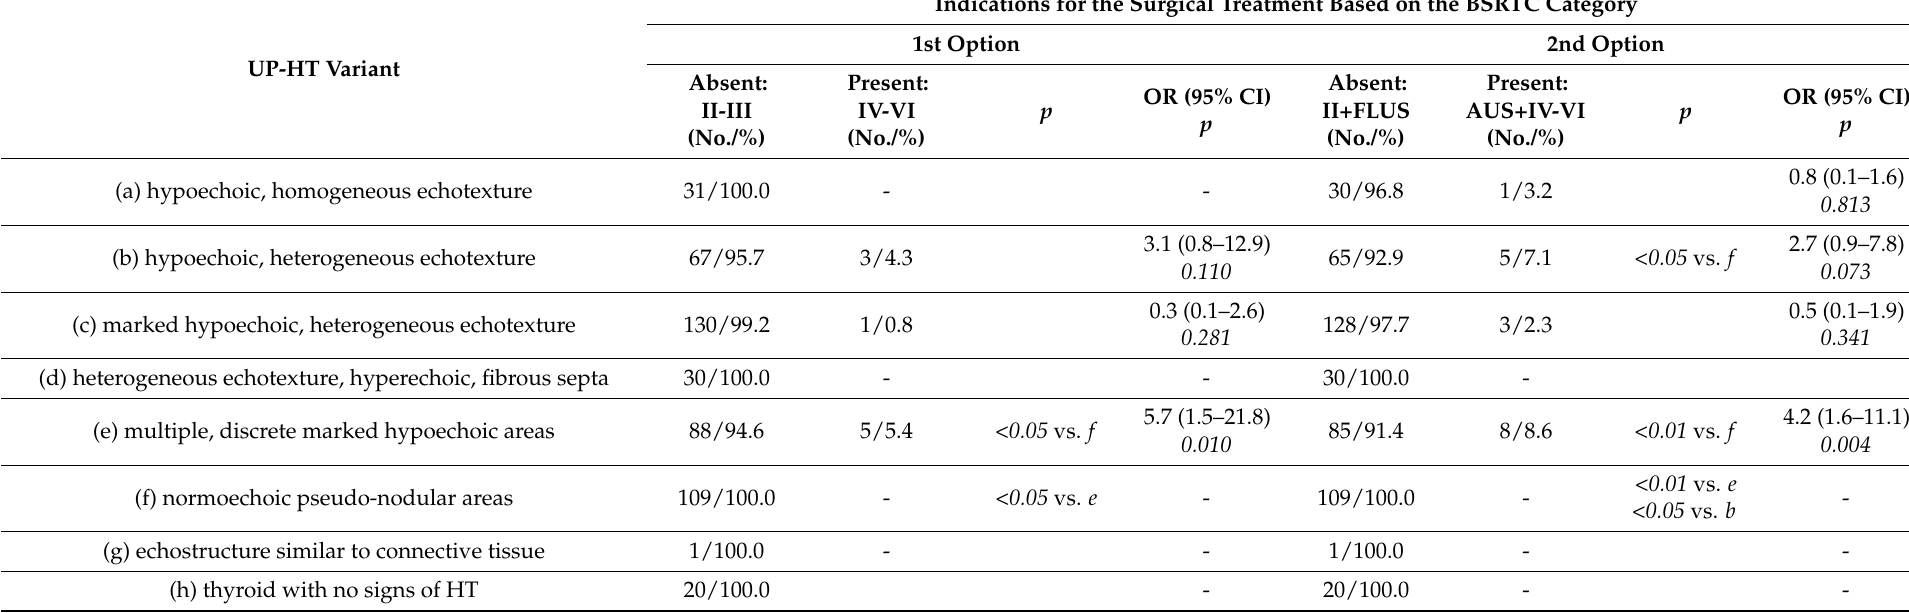
Table 4. Indications for the surgical treatment on the basis of FNA outcome in relation to the variant of the ultrasound pattern of the thyroid parenchyma (UP-HT) —results of the logistic analysis of regression (OR—odds ratio of the necessity for the surgical